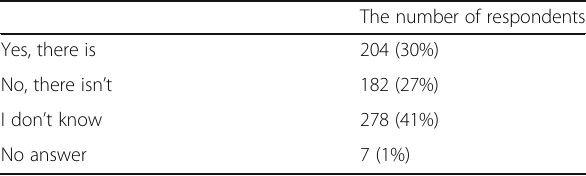
Table 2 Among the patients who received implant